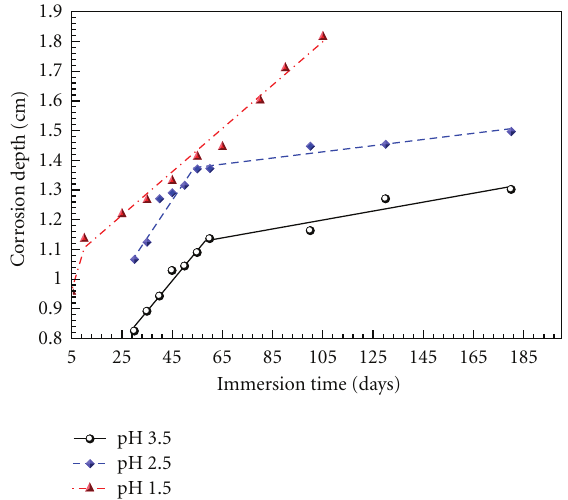
Figure 6: Corrosion depth of concrete specimens immersed in acid